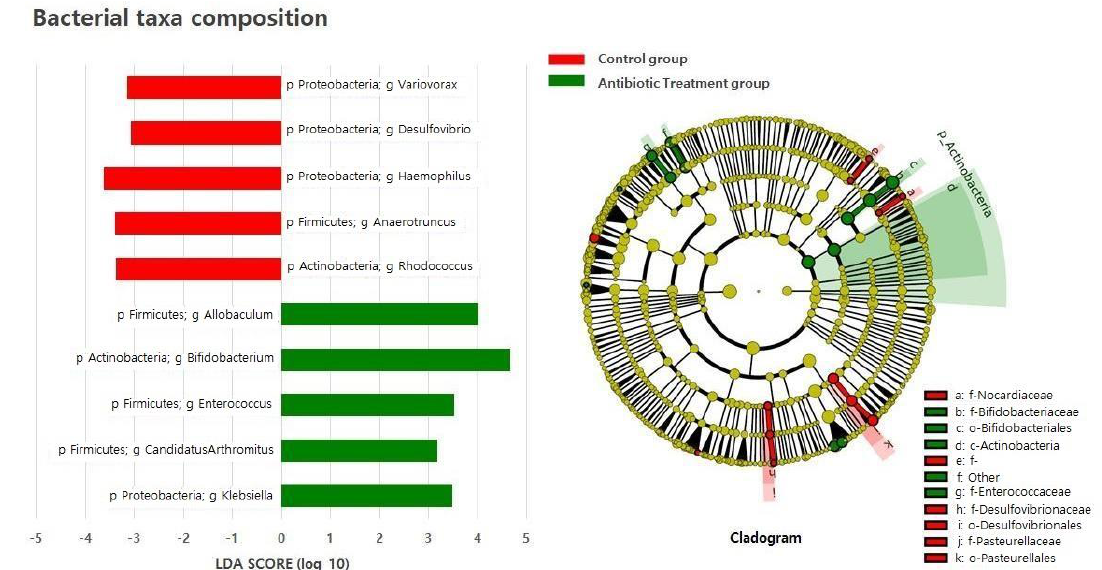
Figure 4. Bacterial taxa composition of the control and antibiotic treatment